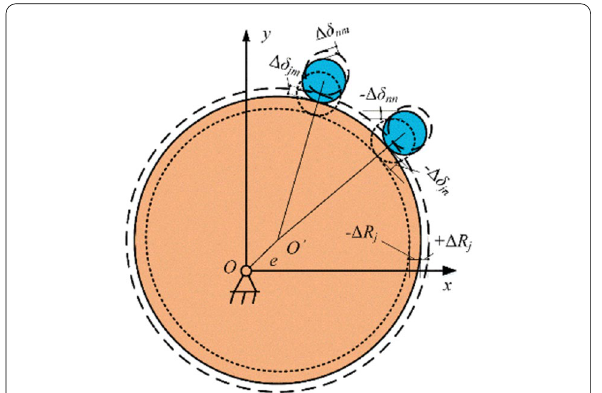
Figure 7 Distortion with manufacturing error of disk cam